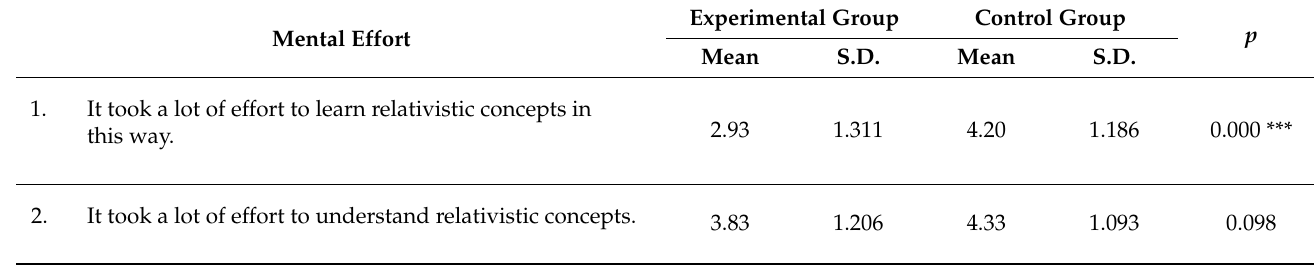
Table 7. Mean, standard deviation, and significance of “mental effort” score for both groups. Experimental Mental Effort